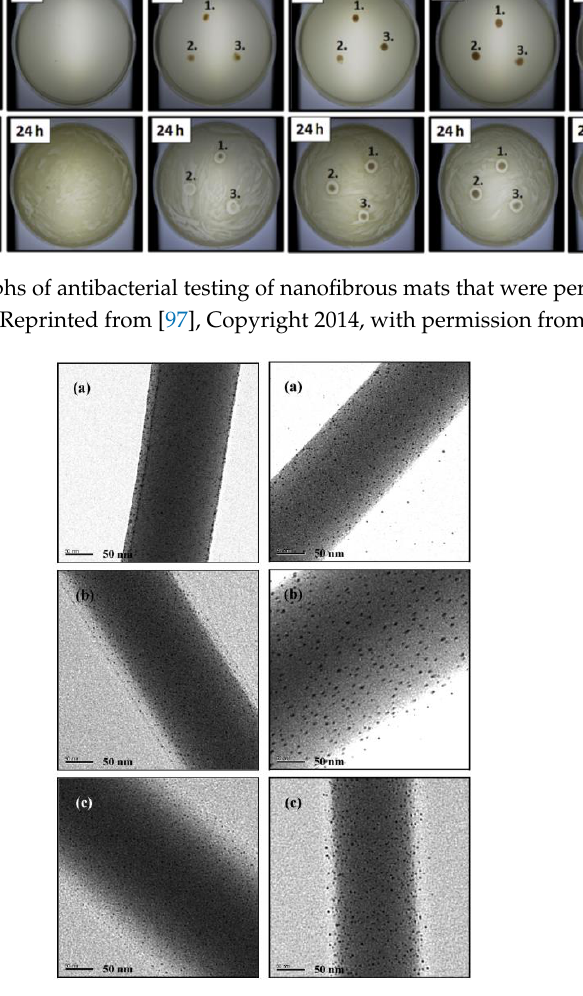
Figure 4. On the ( left ): TEM of PVA nanofibers electrospun from 12 wt% PVA solutions containing 1 wt% of AgNO 3 : ( a ) Not refluxed, ( b ) refluxed at 80 ◦ C for 1 h, and ( c ) refluxed at 80 ◦ C for 2 h. On the ( right ): TEM of PVA (polyvinyl alcohol) nanofibers elect rospun from 12 wt% PVA solutions containing 1 wt% of AgNO 3 after being annealed at ( a ) 50 ◦ C, ( b ) 80 ◦ C, and ( c ) 110 ◦ C for 14 h. Reprinted from [96], Copyright 2007, with permission from